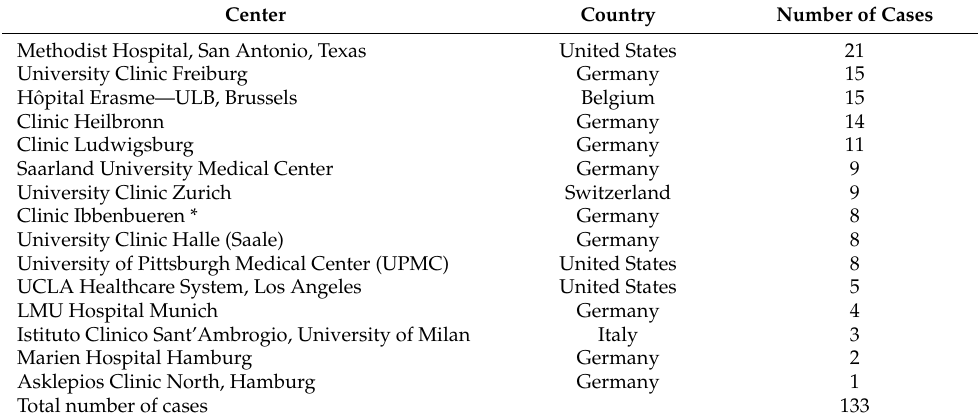
Table 1. Participating centers. Cases included in the registry listed by treatment centers and